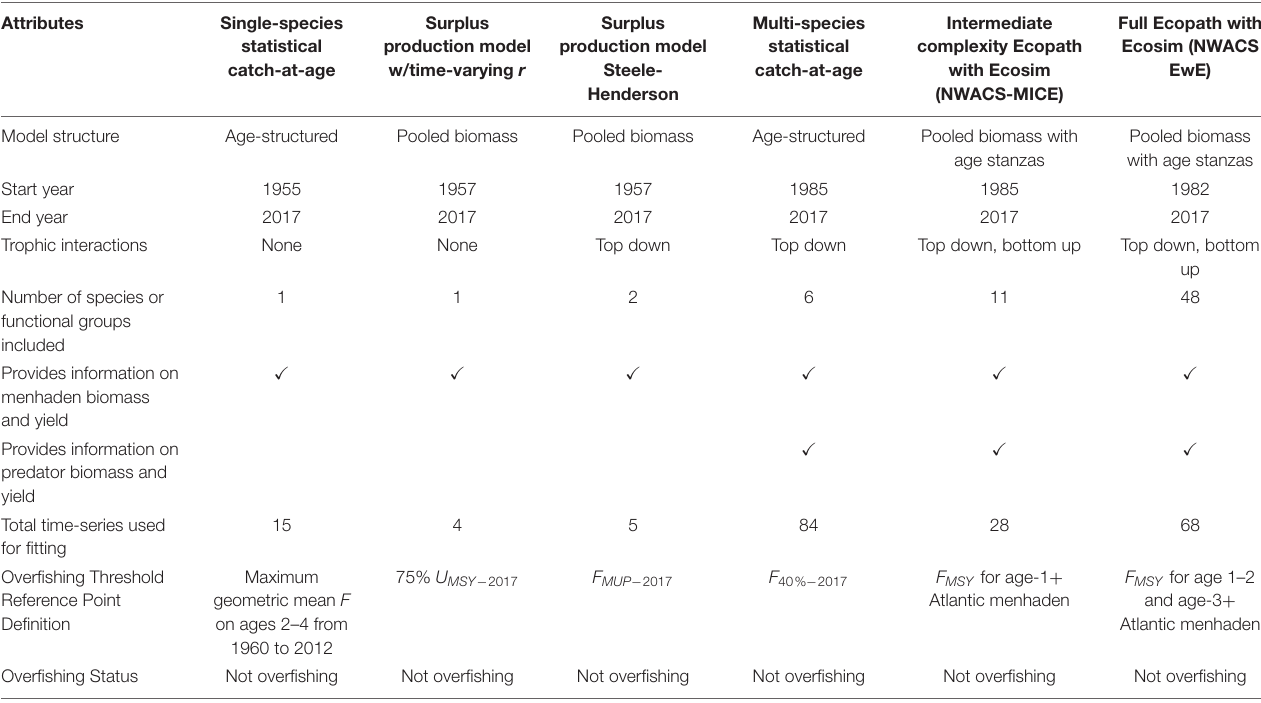
TABLE 3 | Summary of models explored in the development of ecological reference points for Atlantic